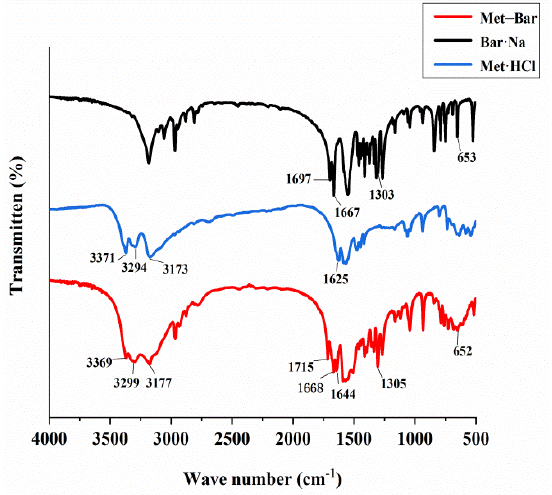
Figure 10. FT-IR spectra of Bar·Na, Met·HCl and Met–Bar.